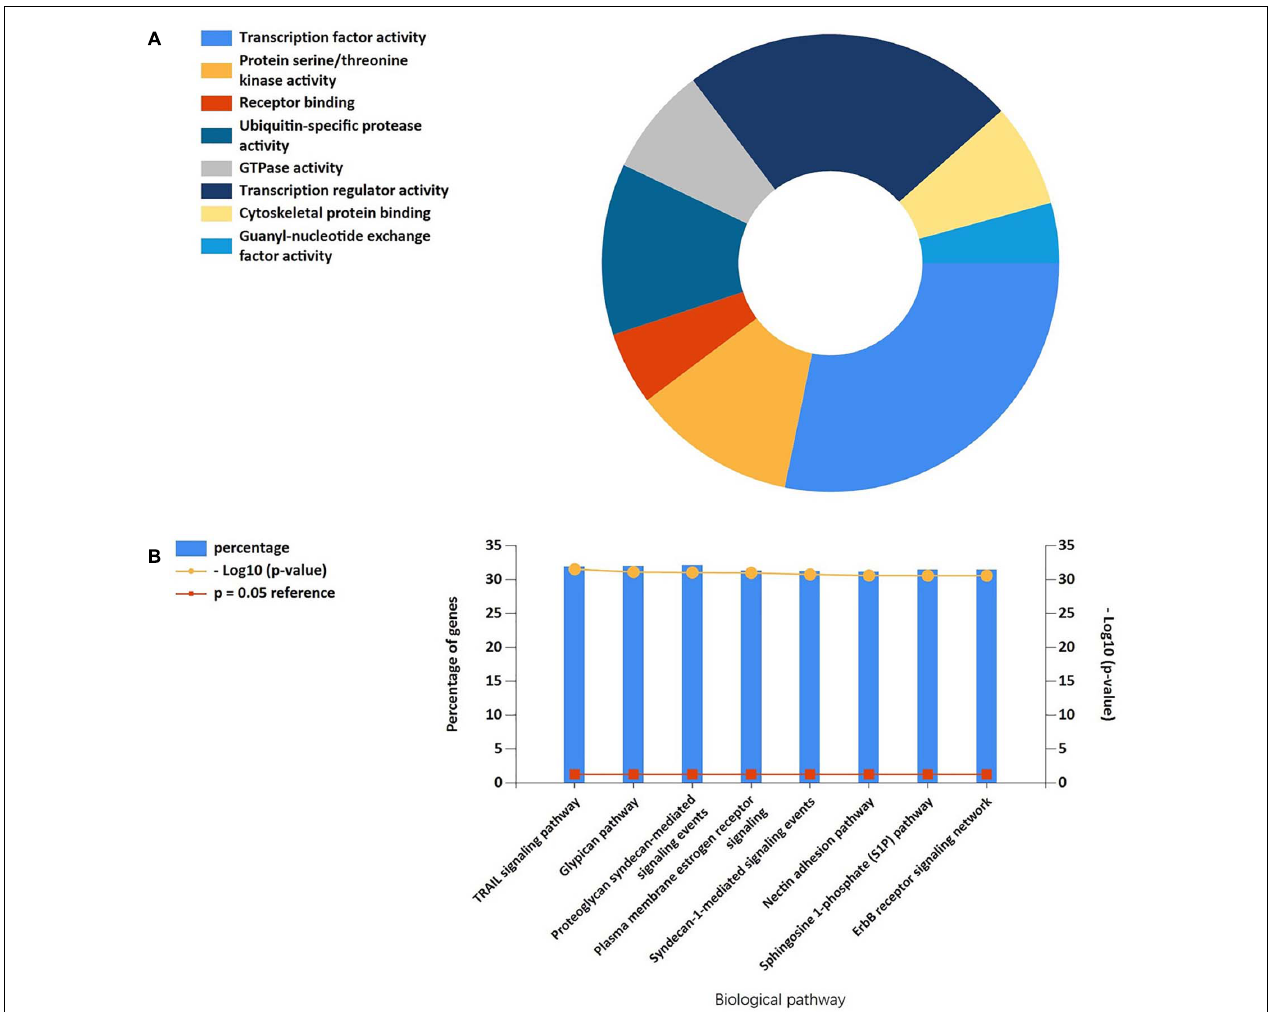
FIGURE 8 | (A) The molecular function of cluster 1-related miRNAs was significantly enriched in the transcription factor activity, protein serine kinase activity, and receptor binding. (B) Biological pathways were enriched in the TRAIL signaling pathway, Glypican pathway, and proteoglycan syndecan-mediated signaling events.